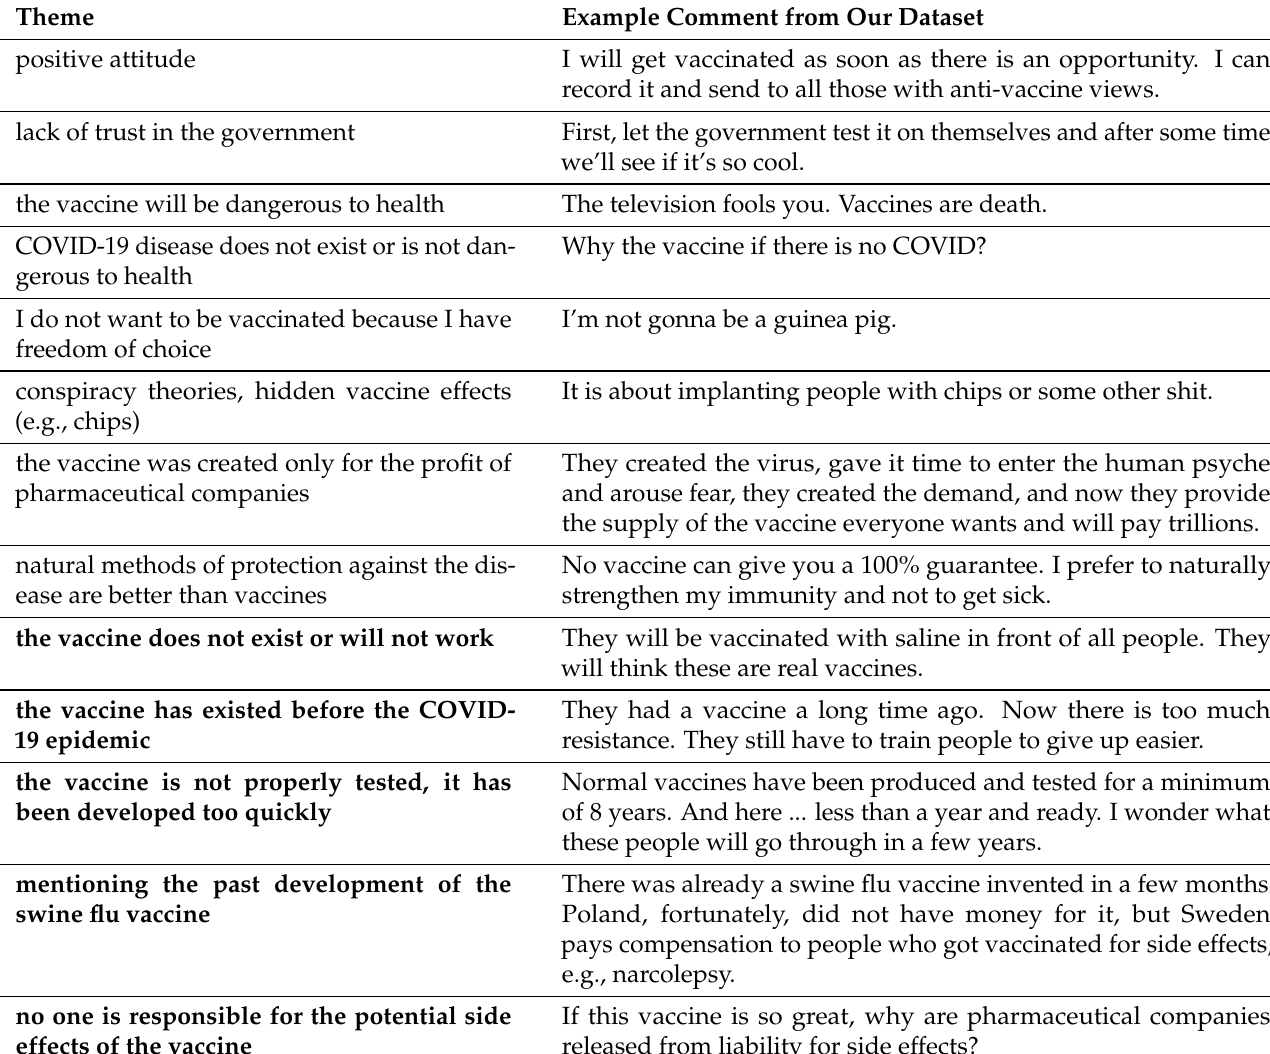
Table 3. Themes of comments and examples from our dataset, new COVID-19 vaccine specific themes are in